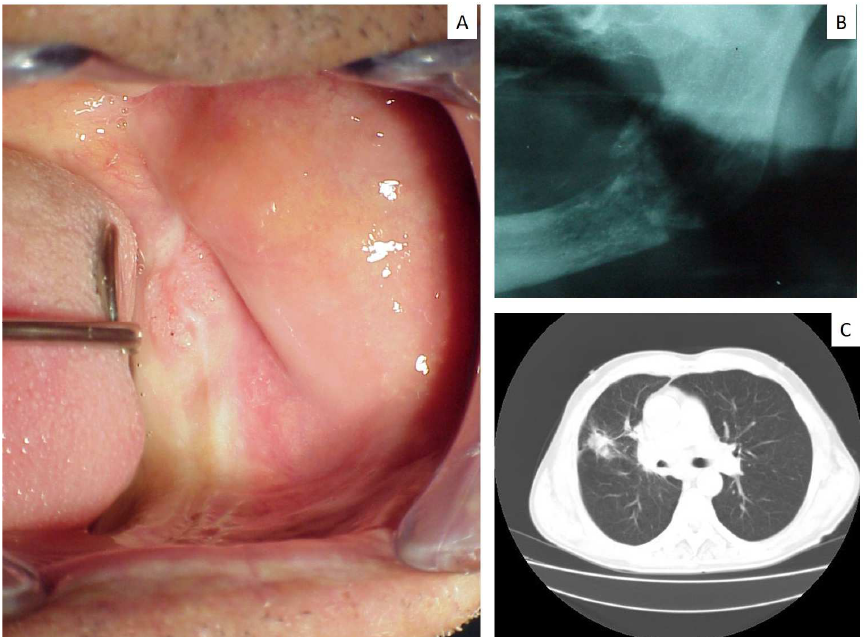
Figure 1. Swelling of the retromolar trigone covered by normally colored mucosa ( A ) with infiltration of the underlining bone ( B ), diagnosed as metastasis from LC ( C ).